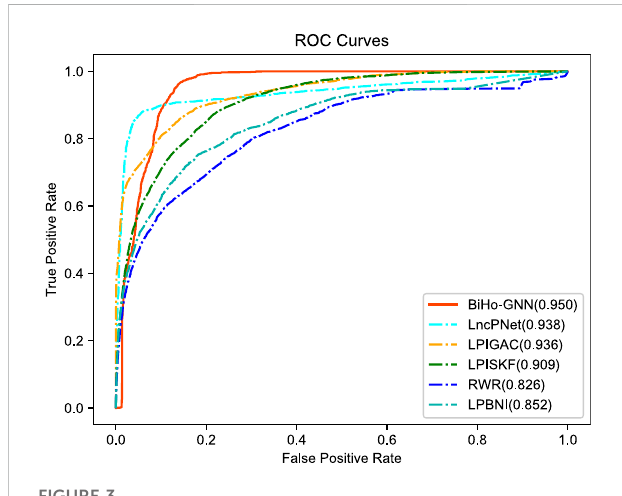
FIGURE 3 The receiver operating characteristic curve for fi ve methods.